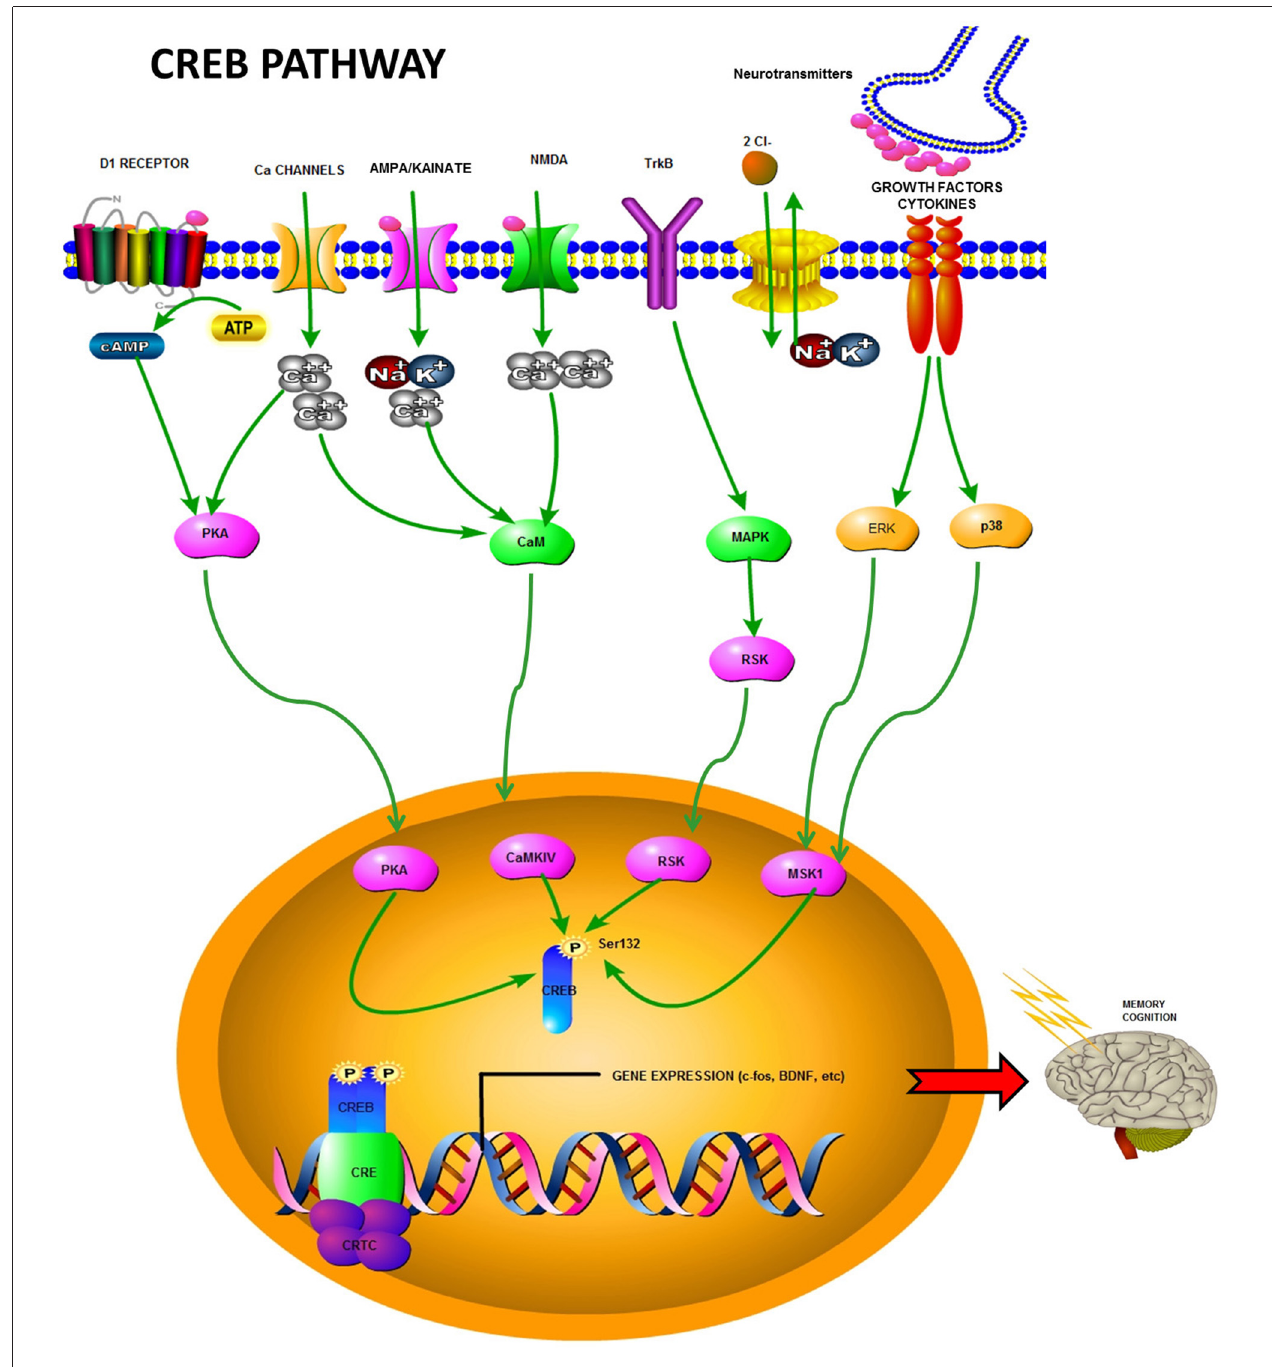
FIGURE 1 | Summary of the CREB pathway highlighting some of the involved receptors, kinases, and other molecules. After activation via phosphorylation, CREB induces transcription of different factors such as c-fos and BDNF, some of which are involved in memory and cognition.